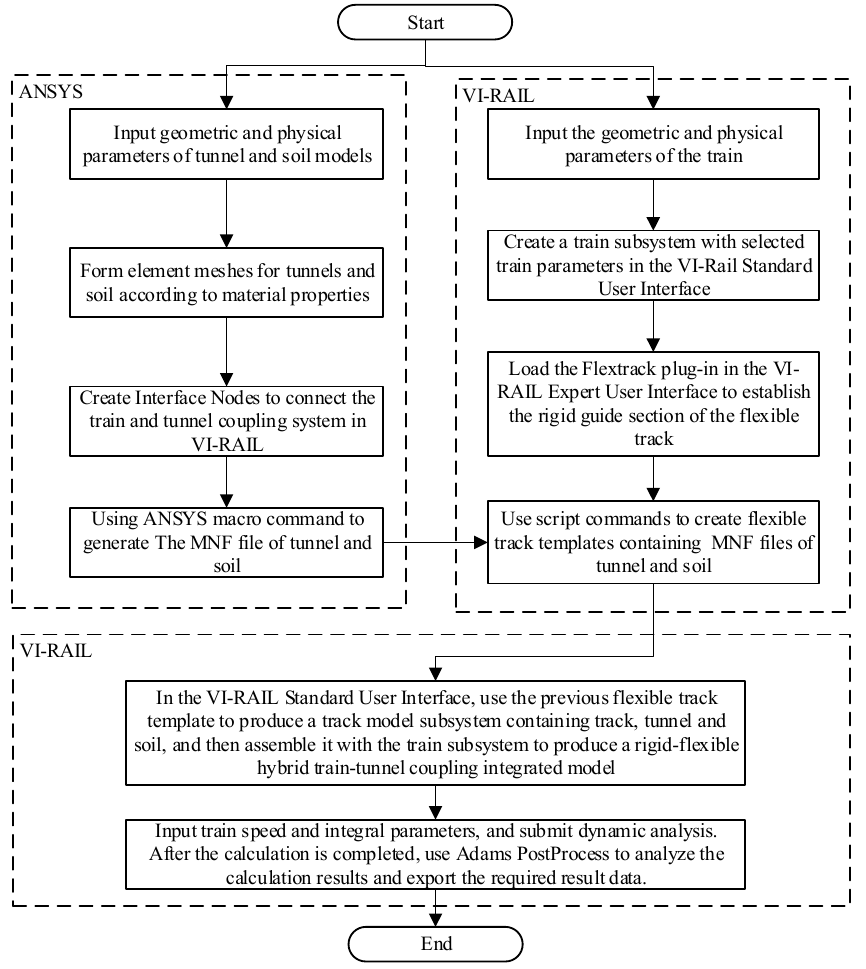
Figure 4. VI-RAIL and ANSYS co-simulation of vehicle–tunnel coupling 3D model modeling pro- cess.